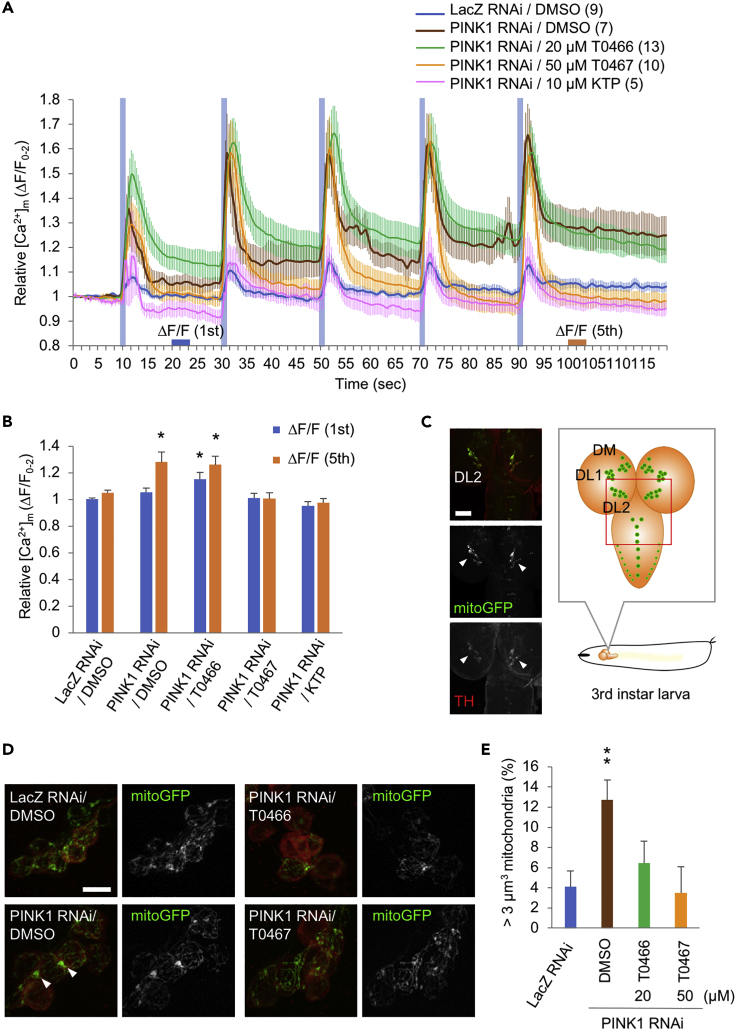
T0466 and T0467 Suppress the Mitochondrial Aggregation of Dopaminergic Neurons Caused by the Reduced PINK1 Activity in Drosophila(A and B) Reduced PINK1 activity-induced delay in mitochondrial Ca2+ efflux is improved by T0467 and KTP. (A) Traces of relative fluorescence intensity changes before and after stimulations were graphed (n = 5–13 flies). Average fluorescence intensity showing mitochondrial Ca2+ concentration ([Ca2+]m) from 0 to 2 s was set to 1. Blue bar indicates electrical stimulation (500 msec at 2.5 V). The number of samples analyzed are indicated in the graph legends. (B) Mitochondrial Ca2+ decay after the first and fifth electrical stimulation (20–22 and 100–102 s) in (A). ∗p < 0.05 versus LacZ RNAi in each time window by Dunnett's test. Data are presented as mean ± SEM in (A) and (B).(C) The DL2 clusters of dopaminergic neurons in the third-instar larval brain. (Left) The posterior brain of larva expressing mitoGFP (green) under the control of TH-GAL4 driver. The DL2 dopaminergic neurons (arrowheads) were also visualized with anti-TH (red). Scale bar, 50 μm. (Right) The position of the larval DL2 neuron clusters is depicted. The left images correspond to the red box region. DL, dorsolateral neurons; DM, dorsomedial neurons.(D and E) Mitochondrial aggregates due to PINK1 inactivation are suppressed by T0466 and T0467. (D) The mitochondrial morphology (visualized by mitoGFP, green) of the DL2 cluster dopaminergic neurons (marked by anti-TH, red) treated with DMSO or the indicated drugs were imaged. Presented images were reconstructed from a series of z-stacked images (10–20 μm in depth). Scale bar, 10 μm. (E) Mitochondrial aggregates over 3 μm3 (as shown by arrowheads in [D]) were graphed (n = 11–21 flies each). ∗∗p < 0.01 versus LacZ RNAi, DMSO using Dunnett's test.All transgenes were expressed by the MHC-GAL4 (A, B) and TH-GAL4 drivers (C–E).See also Figure S5C.